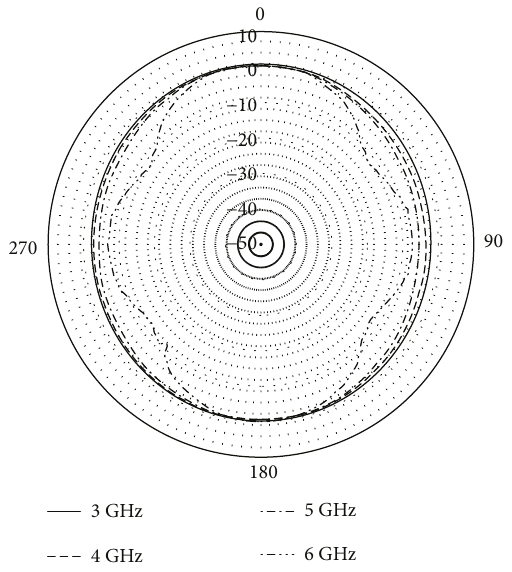
Figure 11: Measured radiation pattern on the XY plane at 3, 4, 5, and 6